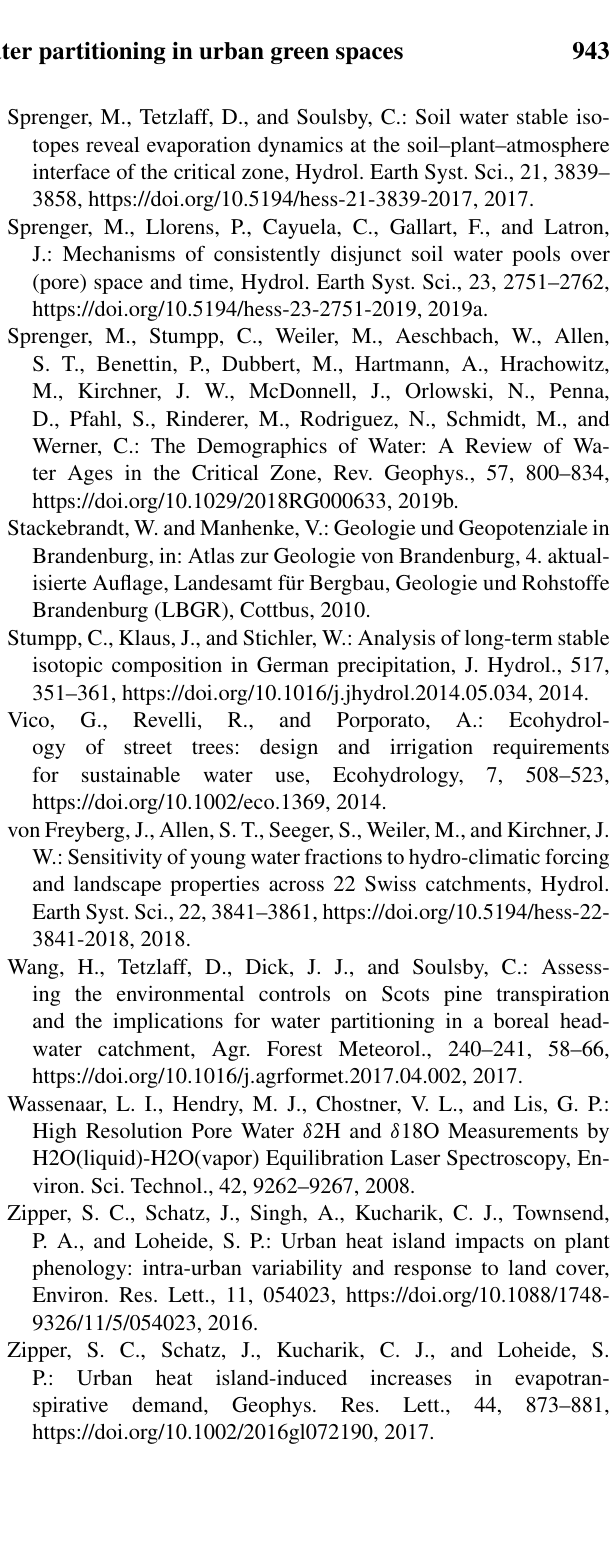
ter Table, available at: https://www.stadtentwicklung.berlin.de/ umwelt/umweltatlas/eid207.htm (last access: 10 August 2020),